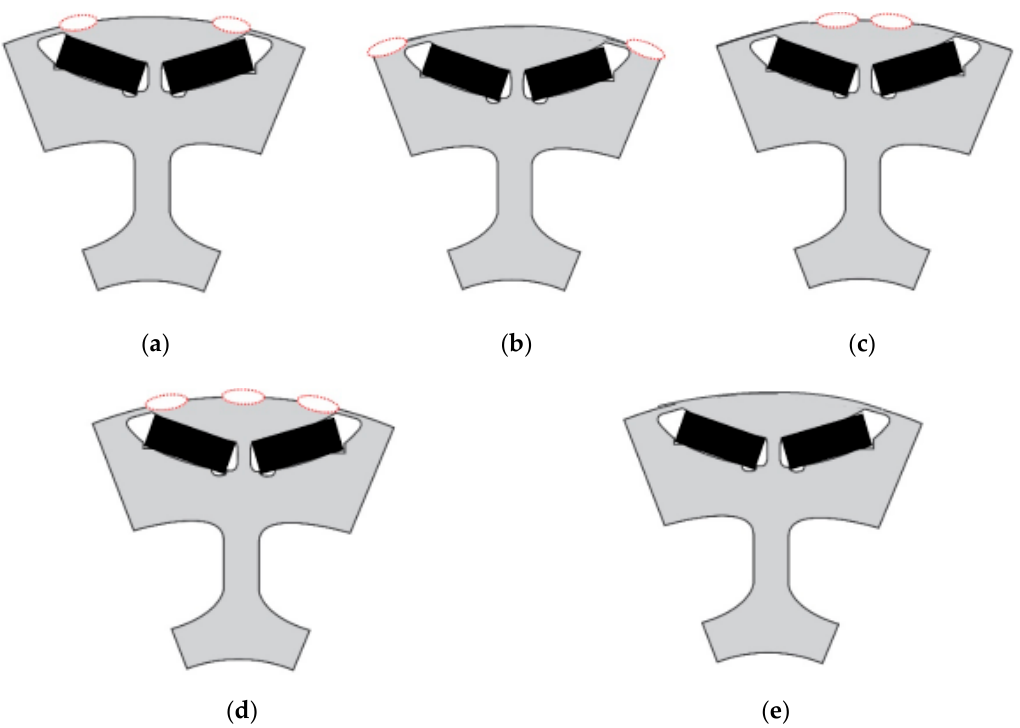
Figure 2. Motor rotor notch design positions: ( a ) magnet’s inner notches; ( b ) magnet’s outer notches; ( c ) magnet’s central notches; ( d ) magnet’s additional central notches; ( e ) no notches (basic form).